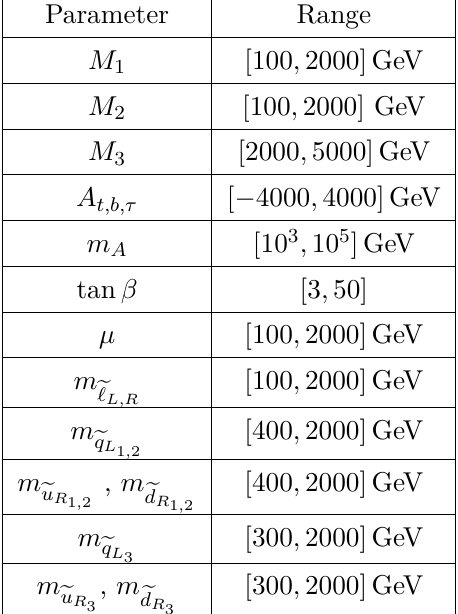
Table 1. Ranges of parameters, defined at the scale Λ = 3 TeV, for the MSSM scan described in subsection